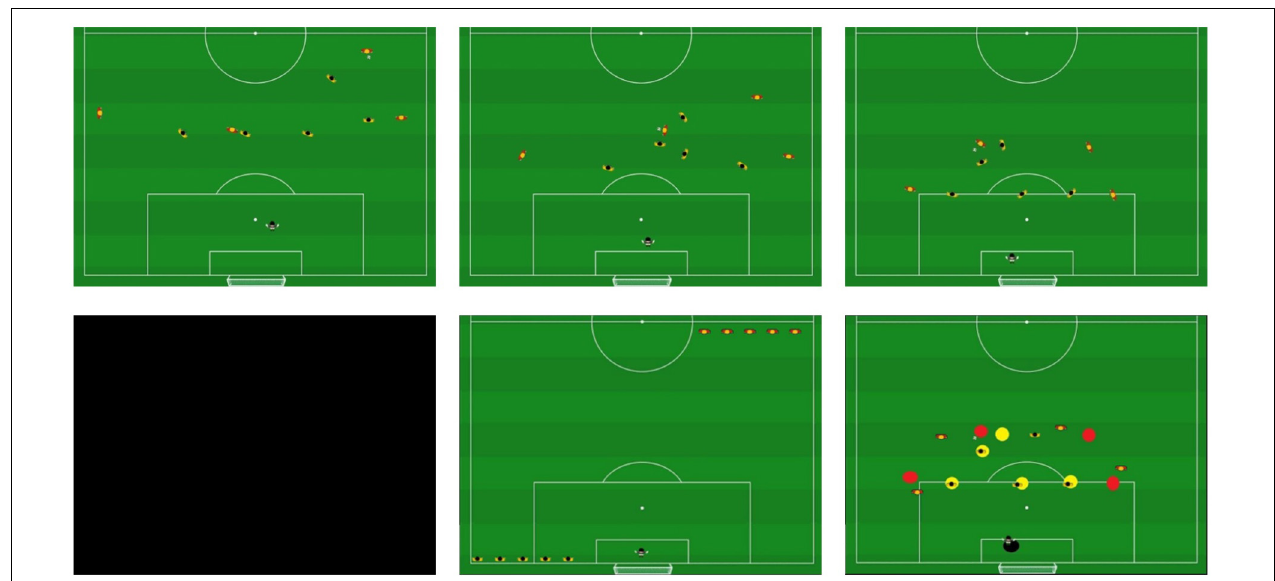
FIGURE 1 | Schematic presentation of the pattern recall task. In row 1, a series of images shows the animations presented to the participants during the task. The last image is an example representing the “frozen” frame at the end of the animation. The black image (row 2, left image) was followed by a recall screen (row 2, middle image). During training players received feedback as demonstrated in row 2, right